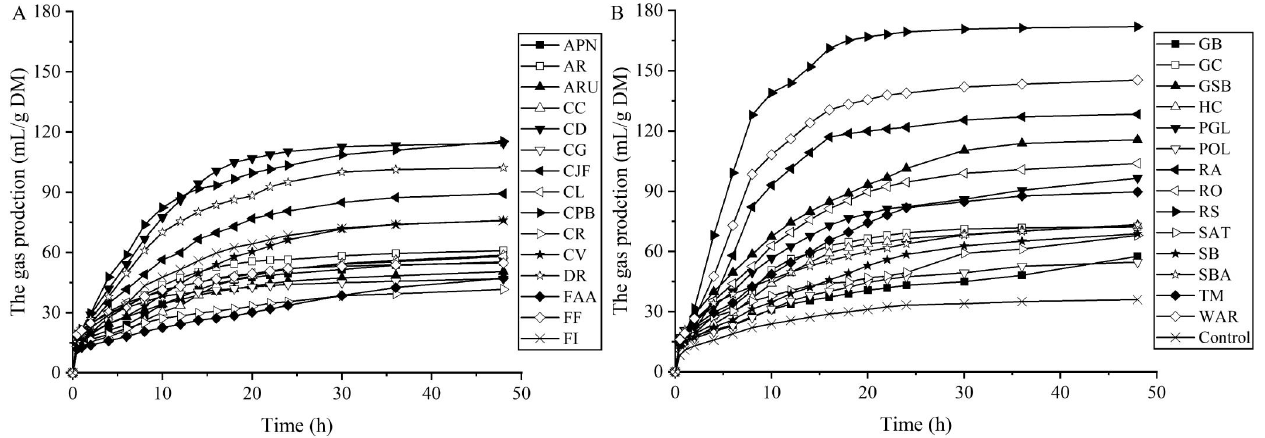
Figure 1. The kinetics of gas production of 29 different Chinese herbs at 48 h of in vitro incubation ( A and B ) . 3.4. Short-Chain Fatty Acids (SCFAs) Concentration and pH Value of Different Chinese